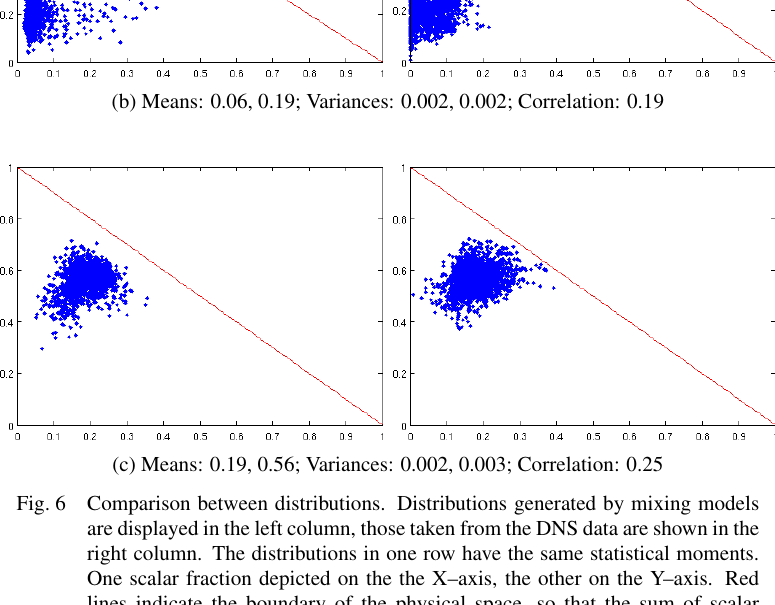
Fig. 6 Comparison between distributions. Distributions generated by mixing models are displayed in the left column, those taken from the DNS data are shown in the right column. The distributions in one row have the same statistical moments. One scalar fraction depicted on the the X–axis, the other on the Y–axis. Red lines indicate the boundary of the physical space, so that the sum of scalar fractions does not exceed